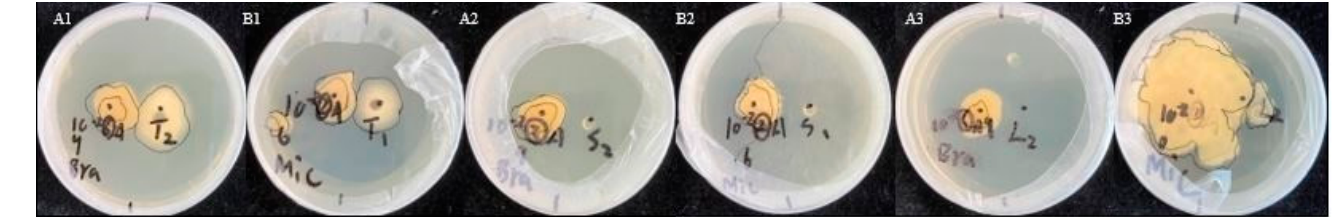
Figure 6. Cogrowth of actinomycetes and fungi. ( A ) Brachybacterium phenoliresistens MO. ( B ) Microbacterium sp. ( 1 ) Colletotrichum siamense , ( 2 ) Rhizoctonia solani , and ( 3 ) Peronophthora litchii .